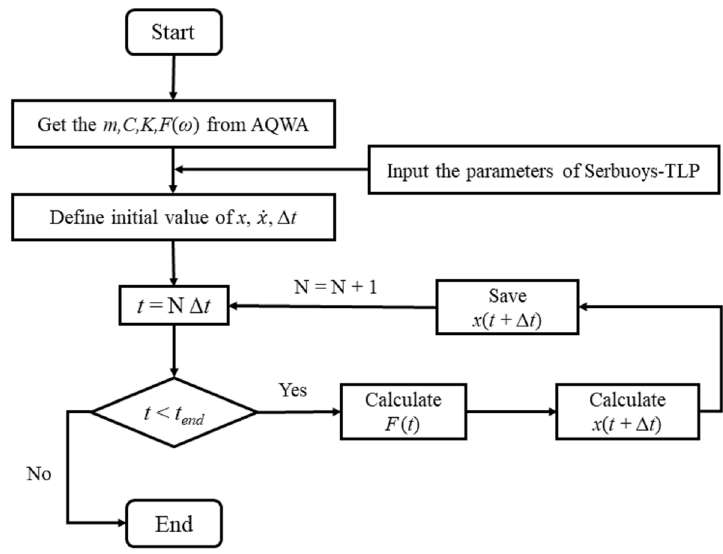
Figure 4. Solution flow chart of DUTMST 2.0.